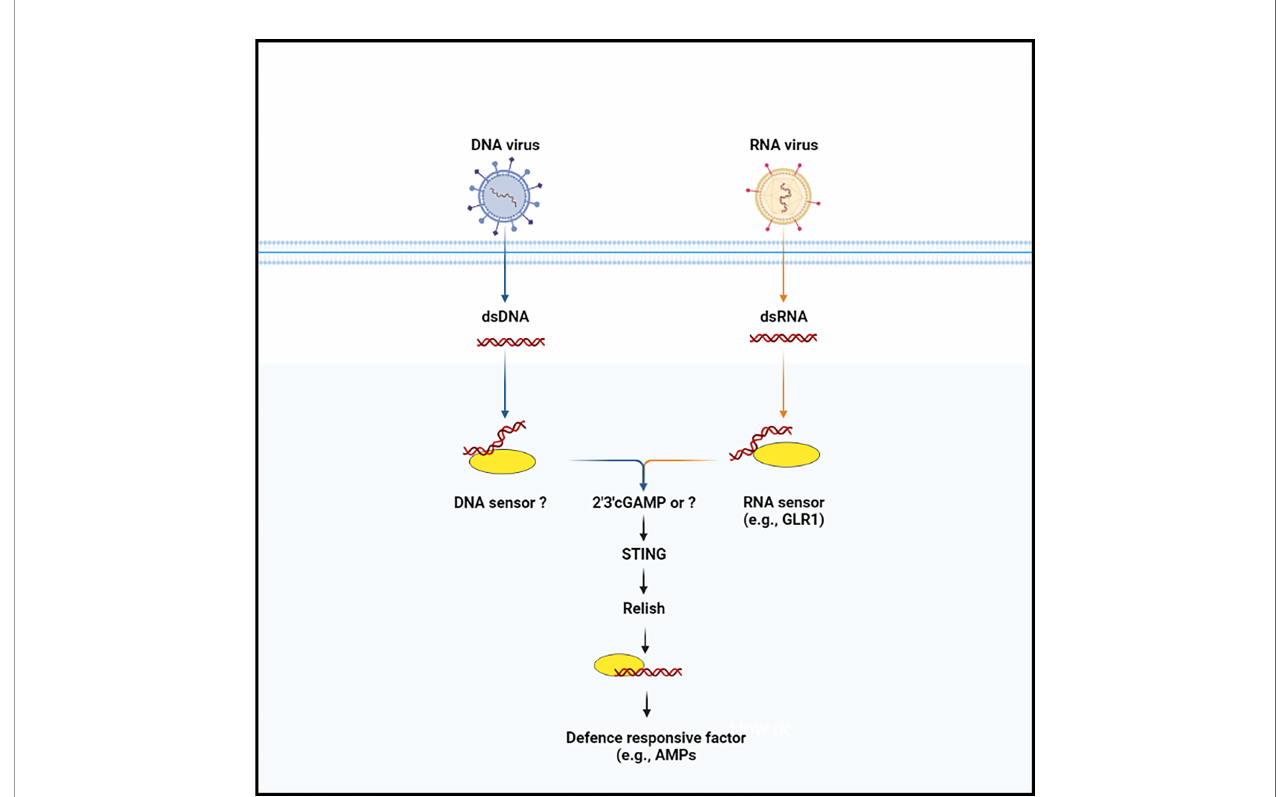
FIGURE 2 | The anti-microbial defense signaling pathway (cGAS-STING pathway) in insects. Nucleic acid (DNA or RNA) is not usually occurred in the cytoplasm of the insect cells. When the enzymatic protein cGAS (cGLR or unknown molecule) recognize nucleic acid, they lead to trigger the synthesize of secondary messenger molecules (e.g., 2 ’ 3 ’ -cGAMP). Following the synthesize of secondary molecules, STING protein is induced, which then binds with the Relish and promotes its translocation, by which in induces anti-microbial